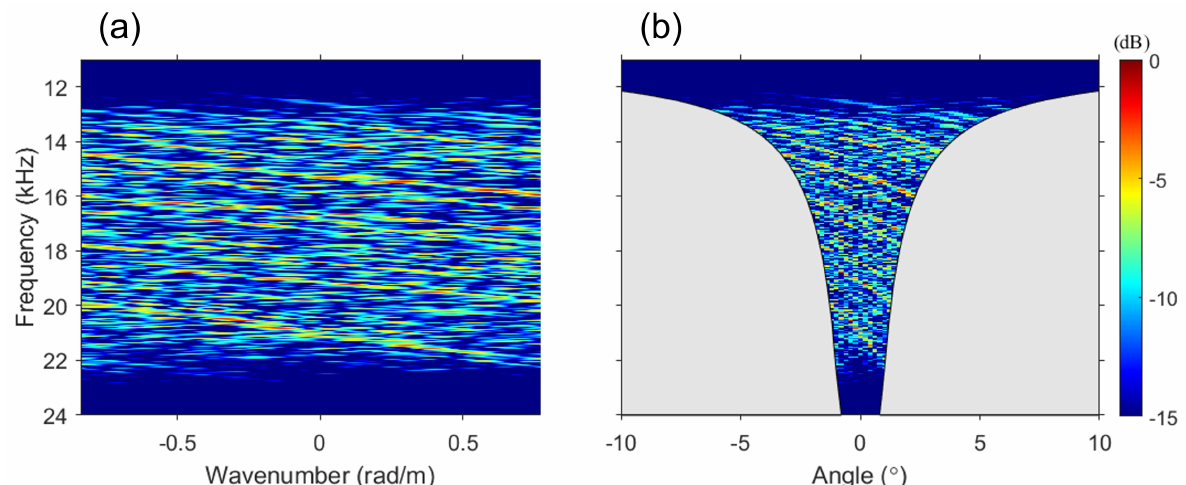
Figure 2. f – k analysis of the simulation data, with the geometry shown in Figure 1; ( a ) frequency–wavenumber domain, and ( b ) frequency–angle domain. A 60-ms cosine-tapered linear frequency modulation chirp in the same frequency band as that generated by the snapping shrimp is utilized for the simulation, resulting in a sparse vertical array configuration. Despite the two-path environment, the f – k analysis is featureless. Because the array configuration is sparse, the gray-shaded region, where the array cannot physically detect the DOA, is extremely wide. Thus, the DOA cannot be estimated due to striation interference by the multipath.